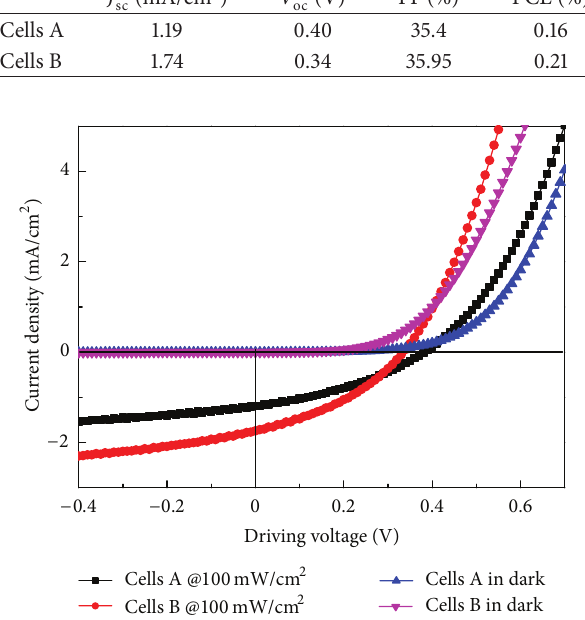
Figure 3: J-V characteristics of two kinds of OPVs under 100mW/cm 2 illumination intensity and in dark